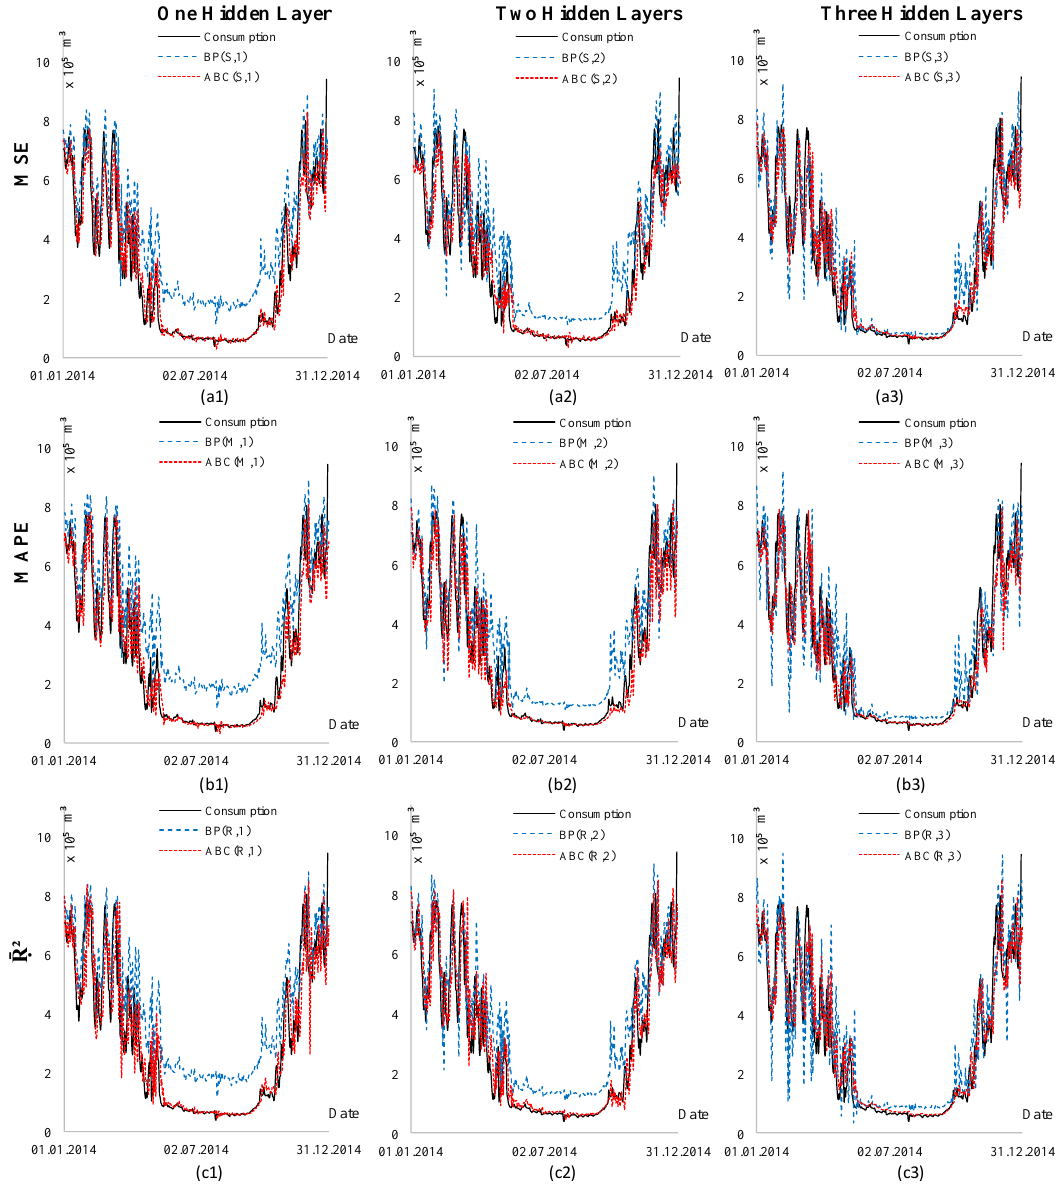
Figure 8. Day-ahead forecasts of the lowest MAPEs. ( a ) Forecast of MSE (mean squared error); ( b ) Forecast of MAPE (mean absolute percentage error); ( c ) Forecast of ¯R. 2